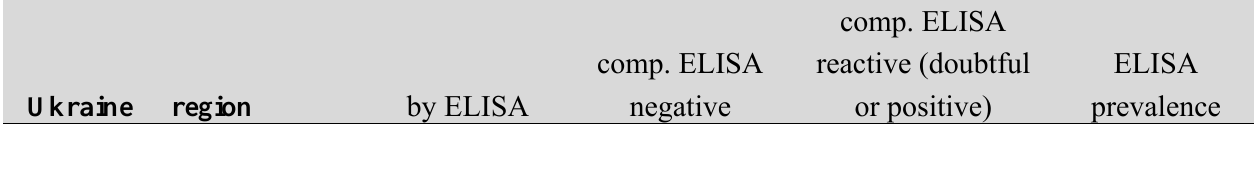
Table 2. Competitive ELISA results stratified by region and regional antibody